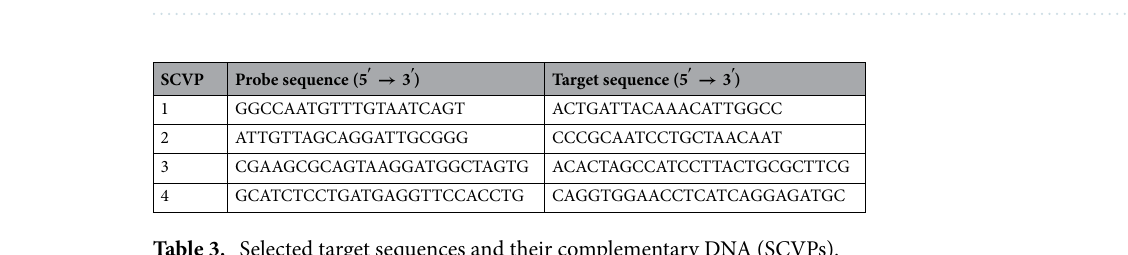
Figure 5. ( a ) The schematic illustration of the dual-platform biosensor and detection mechanism of dual- platform biosensor and ( b ) Schematic illustration of SARS-CoV-2 RNA and designed SCVP complementary regions.